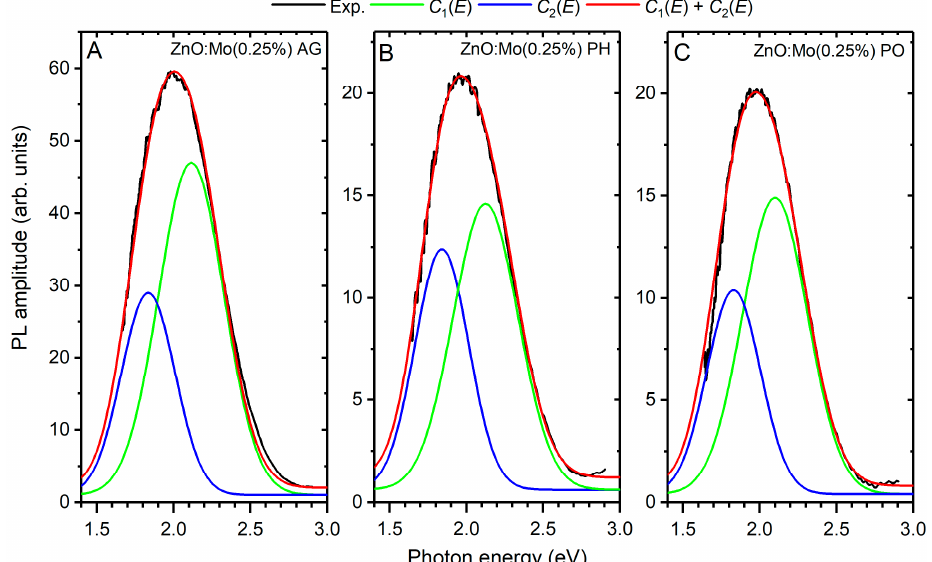
Figure 6. The decomposition of the experimental PL spectrum detected in the AG ( A ), PH ( B ) and PO ( C ) ZnO:Mo(0.25%) sample into the calculated Gaussian ( ) ( C ) ZnO:Mo(0.25%) sample into the calculated Gaussian C 1,2 ( E ) components (as indicated in legends).